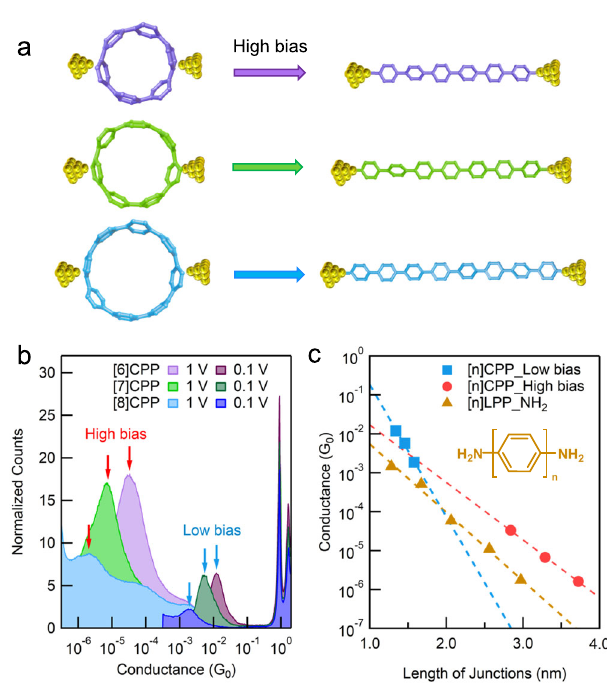
Fig.3|Length-dependentconductanceof[n]CPPs( n =6 – 8).a SchematicsofEAS reactions in [n]CPPs ( n =6 – 8). b 1D conductance histograms for [6]CPP-[8]CPP mea- suredatanappliedlowbiasof0.1Vandanappliedhighbiasof1V. c Conductanceof [6]CPP-[8]CPP determined by Gaussian fi tting the conductance peaks against calcu- lated single CPP and single LPP junction length (Au-Au distance). Conductance of the amino-anchored LPPs obtained from the previous study is included for ref. 38 . The beta value is determined by the slope of the fi tted dished